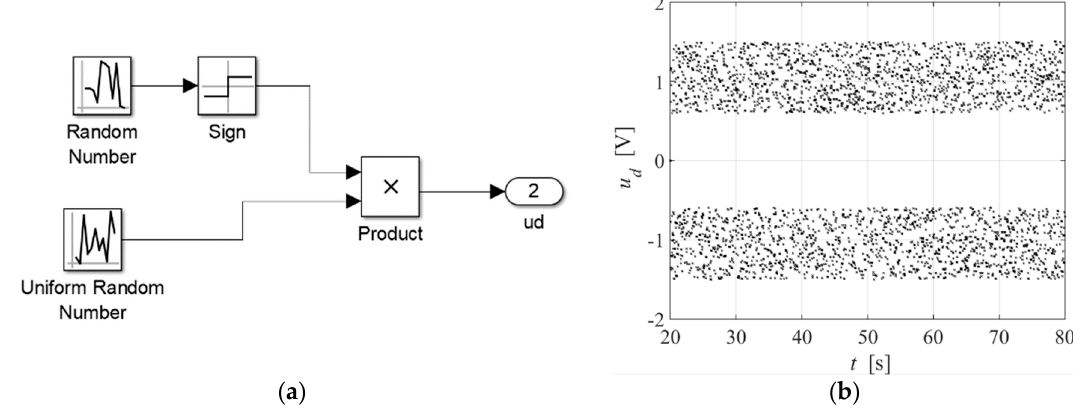
Figure 7. Disturbance signal for identification: ( a ) signal implementation; ( b ) signal output. Table 1. Identification signal parameters.